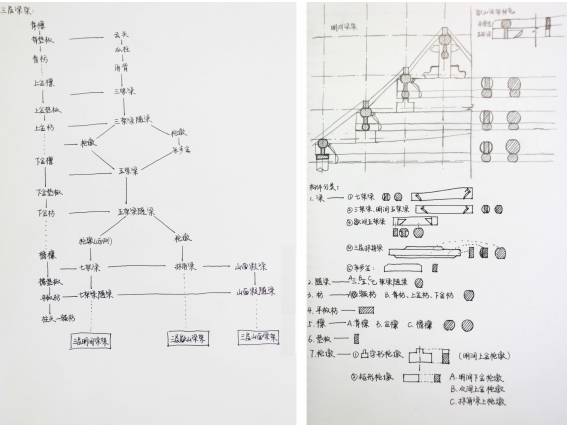
Figure 2. The sketches